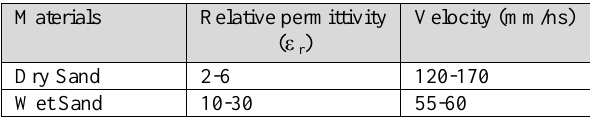
Table 2: Dielectric value for common materials